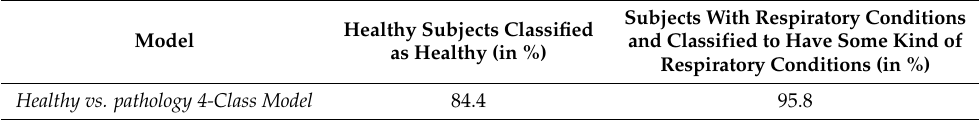
Table 9. Accuracy of Healthy vs. Pathology 4-Class